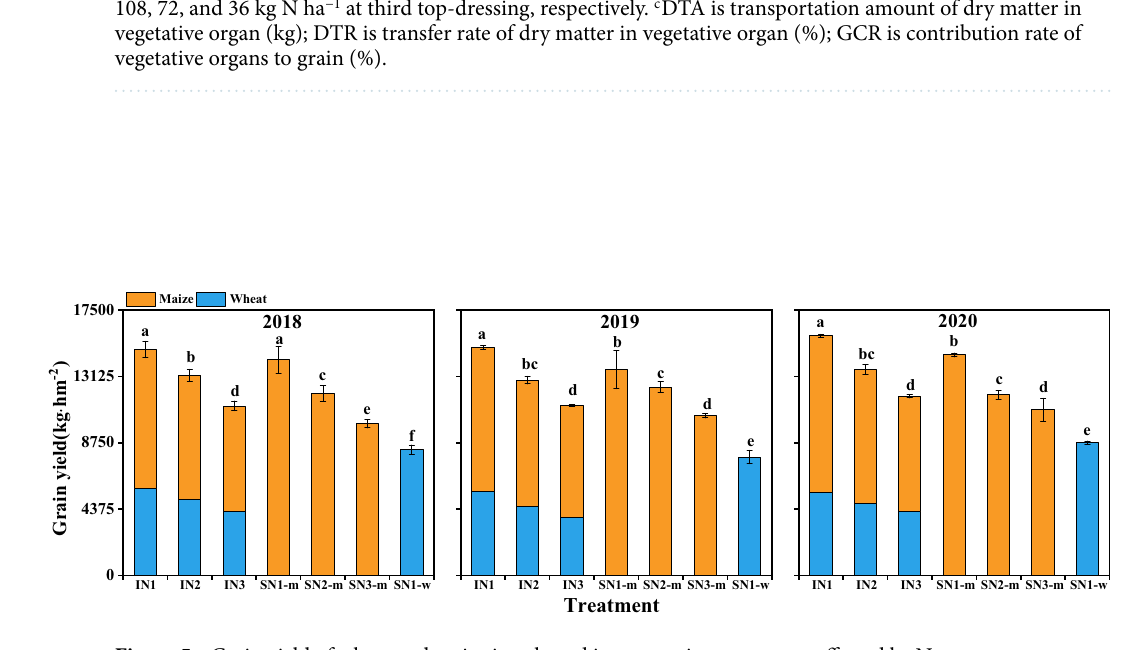
Figure 5. Grain yield of wheat and maize in sole and intercropping systems as affected by N management practices in 2018–2020. I, intercropping, S, sole cropping. For intercropping system, N 1 , N 2 , and N 3 represent N-fertilizer applied at 51, 72, and 93 kg N ha −1 as first top-dressing plus 63, 42, and 21 kg N ha −1 at third top- dressing, respectively. For sole maize, N 1 , N 2 and N 3 represent N-fertilizer applied at 36, 72, and 108 kg N ha −1 as first top-dressing plus 108, 72, and 36 kg N ha −1 at third top-dressing, respectively. For sole wheat, N 1 represents the N-fertilizer applied at 108 kg N ha −1 as base fertilizer at sowing plus 72 kg N ha −1 top-dressed at pre-tasseling. Different lowercase above bars indicates significant difference ( P ≤ 0.05) among different N managements. Error bars indicates standard error of the means ( n =